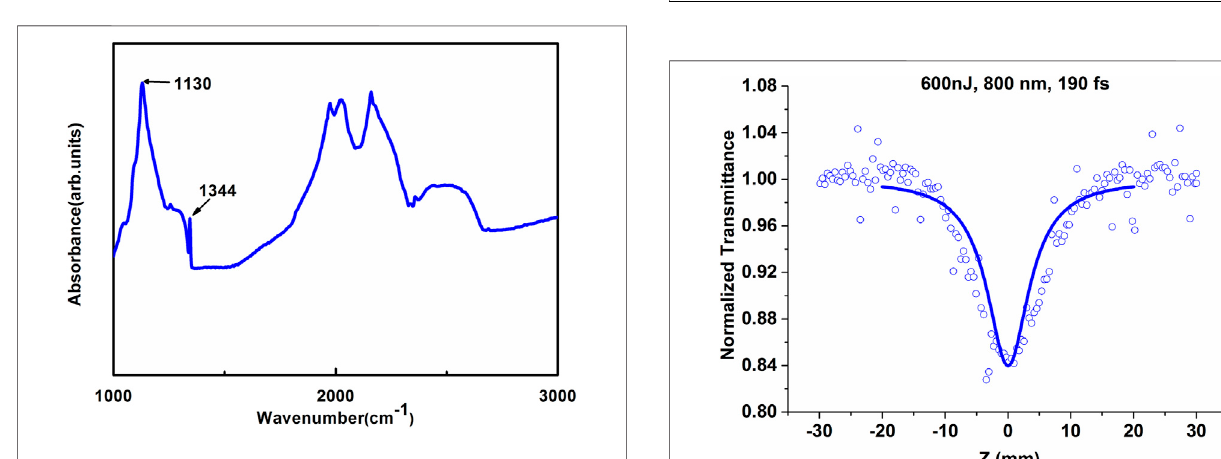
FIGURE 3 | FTIR spectrum of the obtained nitrogen-doped diamond crystal.